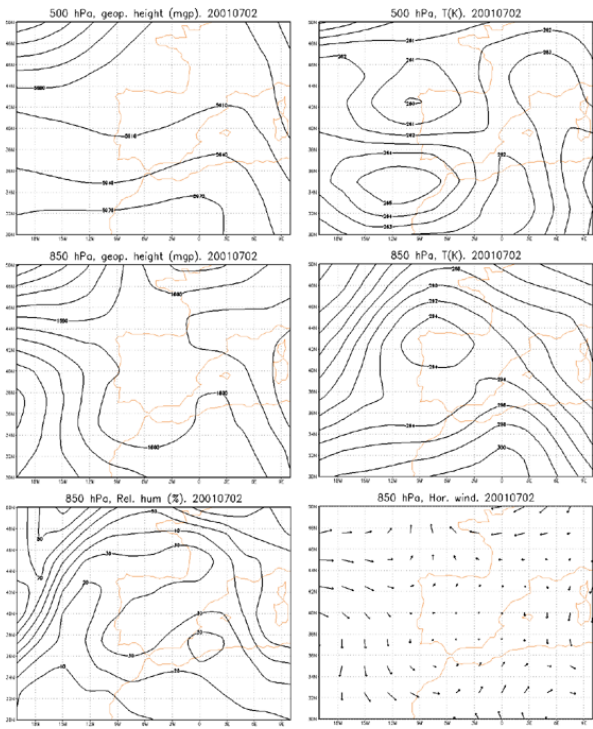
Fig. 16. NCEP reanalysis, 12:00UTC. Date: 23 June 2005, CL5. The atmospheric fields shown are: φ 500 (gpm), T 500 (K), φ 850 (gpm), T 850 (K), rh 850 (%) and wind direction at 850hPa, from left to right.